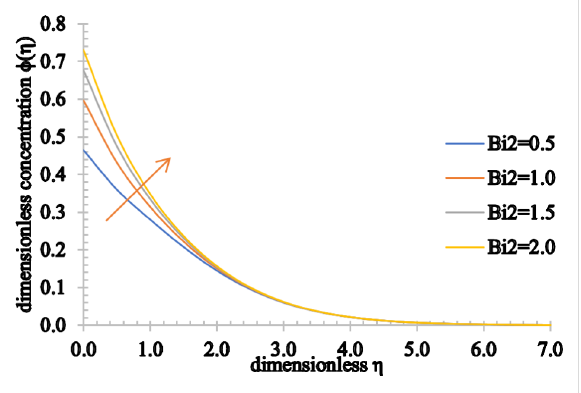
Figure 23: The concentration profile for increasing values of Bi